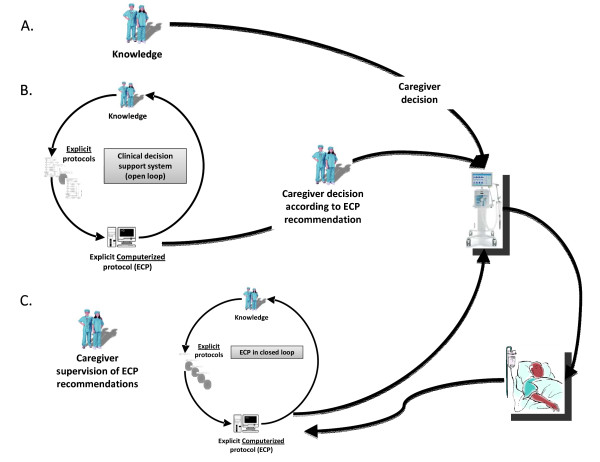
Schematic representation of the different processes for decision making. (A) Actual caregiver decision making. (B) Explicit computerized protocol in open-loop (clinical decision support systems). (C) Explicit computerized protocols in closed-loop.